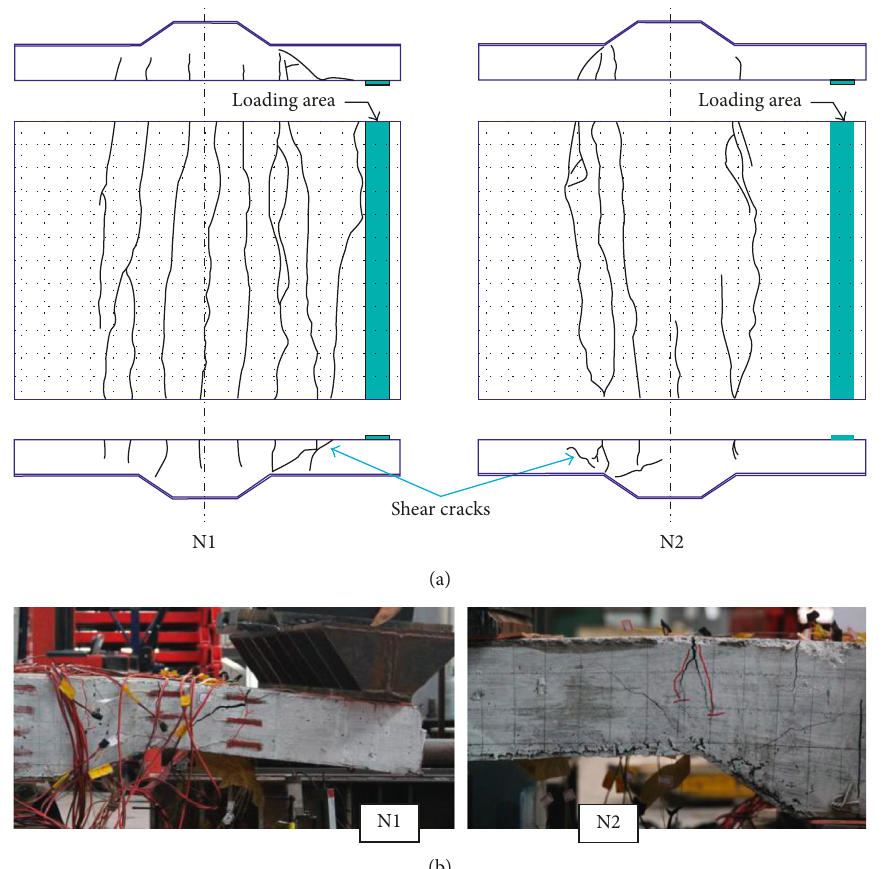
Figure 21: Cracking modes of N1 and N2 specimens. (a) Crack pattern. (b) Photos of shear cracks.